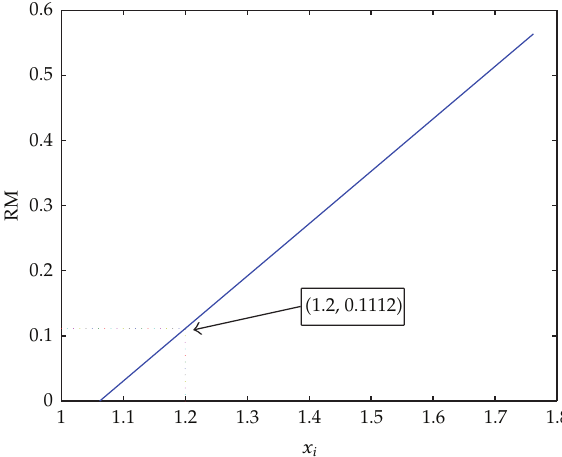
Figure 3: The relationship between RM and ξ